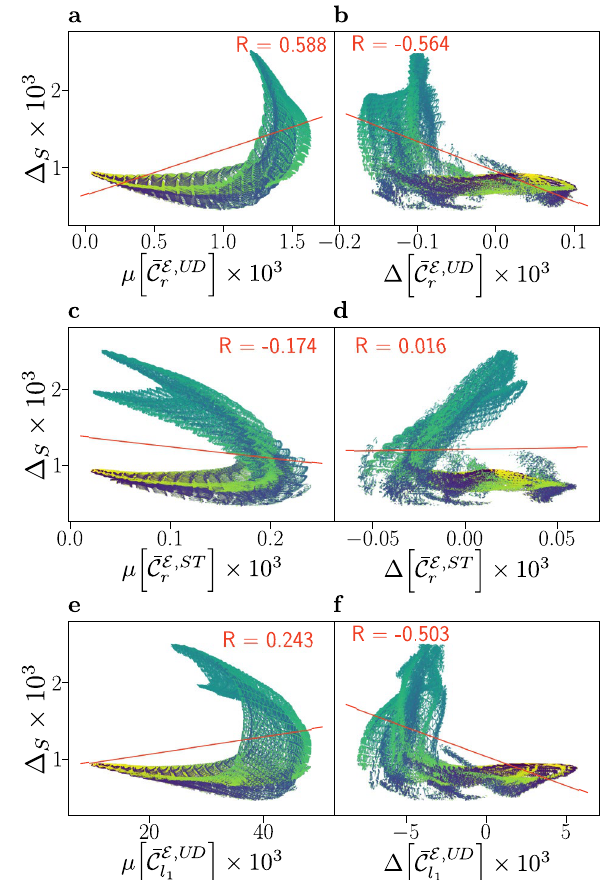
Figure 3. Compass sensitivity, as captured by the anisotropy (cid:31) S , is plotted against electronic coherence measures µ [ ¯ C i ] ( a , c , e ) and (cid:31) [ ¯ C i ] ( b , d , f ), for 878,400 relative orientations of flavin–tyrosine radical pairs. Here, we use equivalent measures to Fig. 2, where additional details are provided; alternative measures are detailed in the SI. Data has been coloured according to the relative orientation angle β , ranging from 0 ◦ (blue) to 180 ◦ (yellow). Both up-down (UD) and singlet-triplet (ST) bases are considered, and a linear fit (red line) with associated Pearson correlation coefficient R is